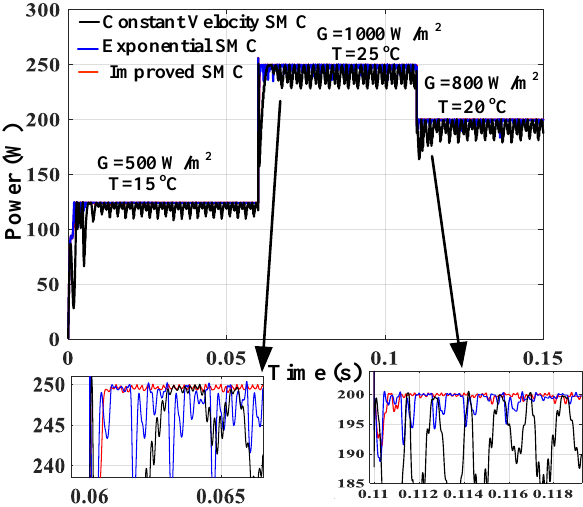
Figure 15. MPPT curve under varying G , T .